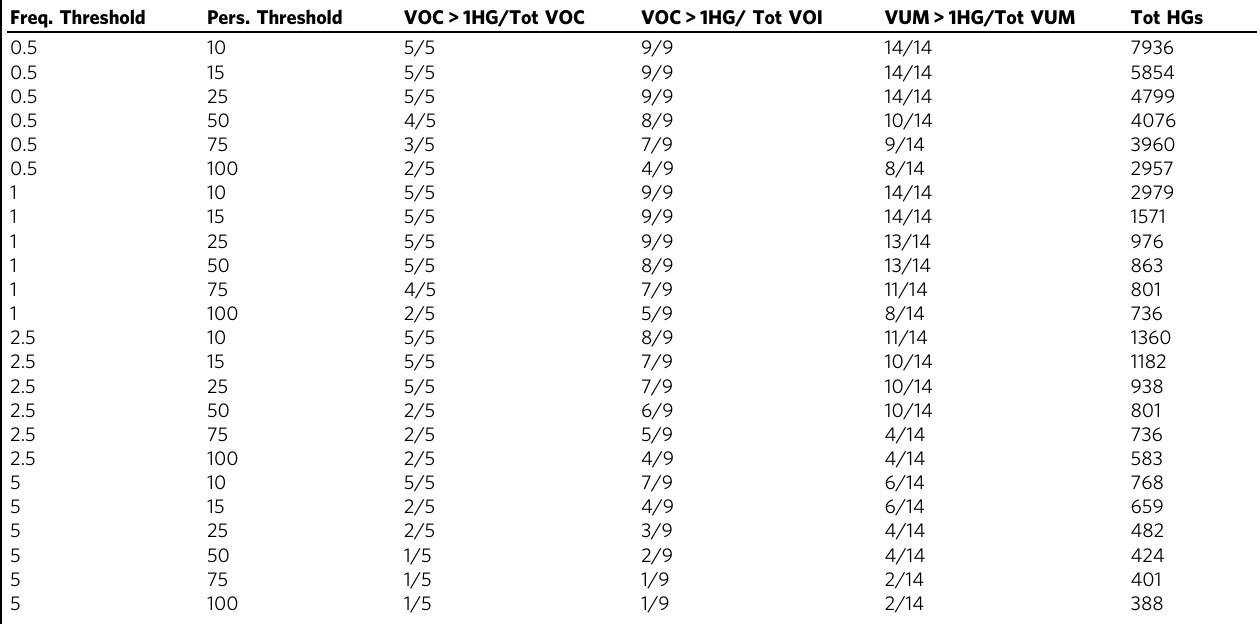
Table 1 Combinations of parameters used in the optimization of phenetic clustering of SARS-CoV-2 genomes. Freq.